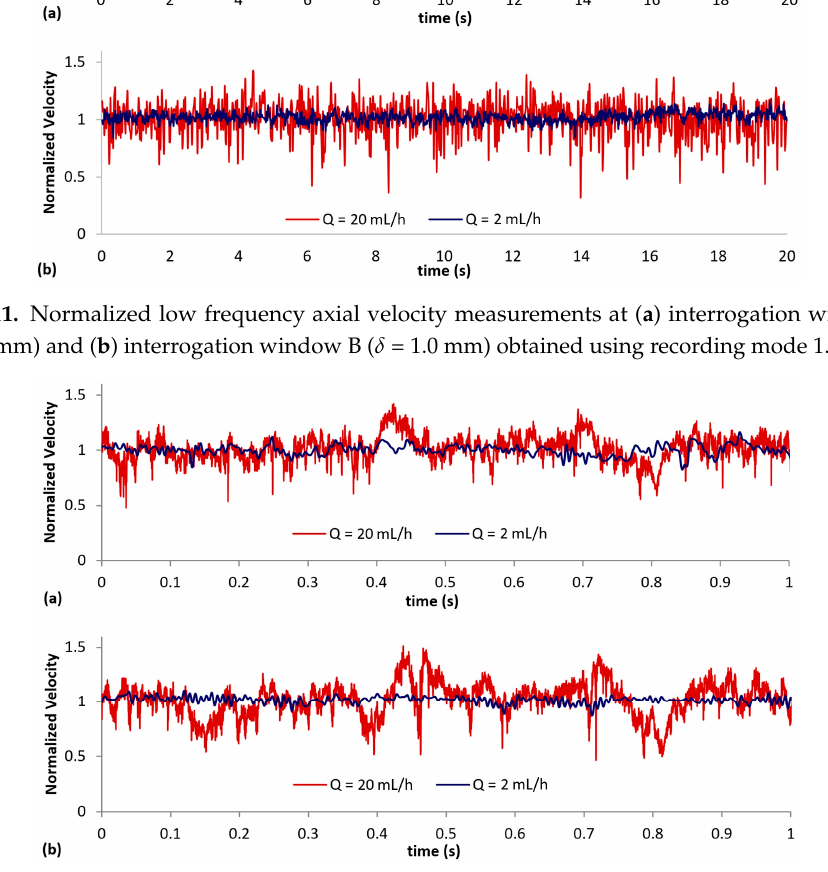
Figure 12. Normalized high frequency axial velocity measurements at ( a ) interrogation window A ( δ = 0.3 mm) and ( b ) interrogation window B ( δ = 1.0 mm) obtained using recording mode 2.